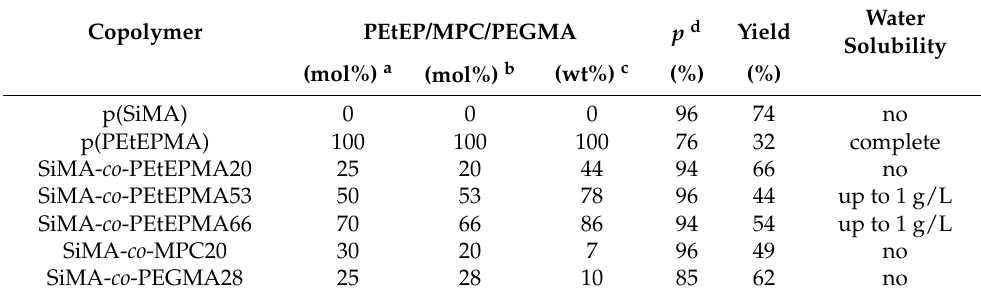
Table 1. Polymerization conditions and chemical-physical properties of SiMA- co -PEtEPx copolymers.